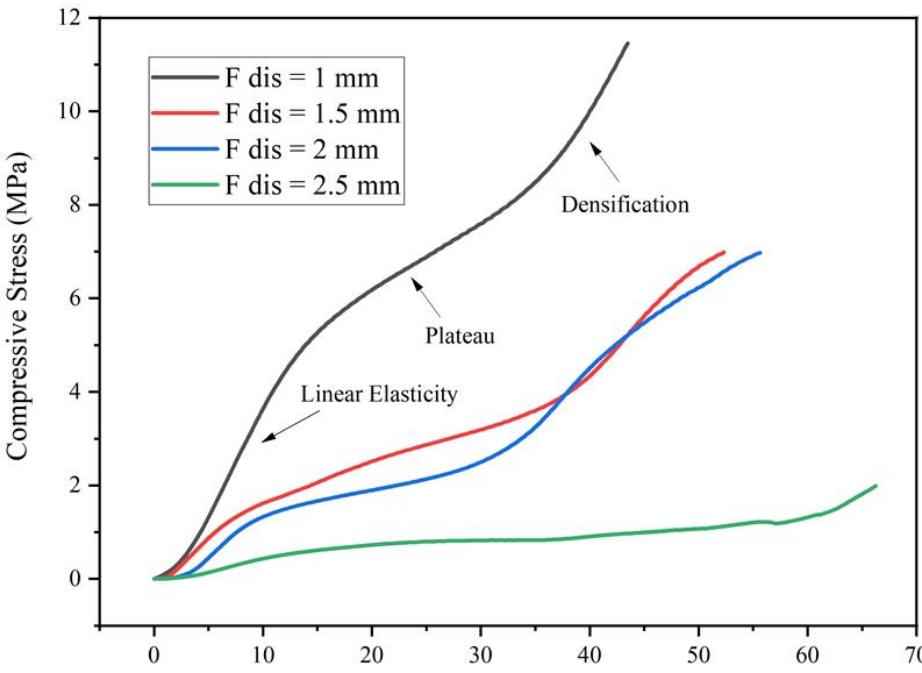
Figure 6. Compressive stress–strain curves for PCL scaffold fabricated with filament distances.